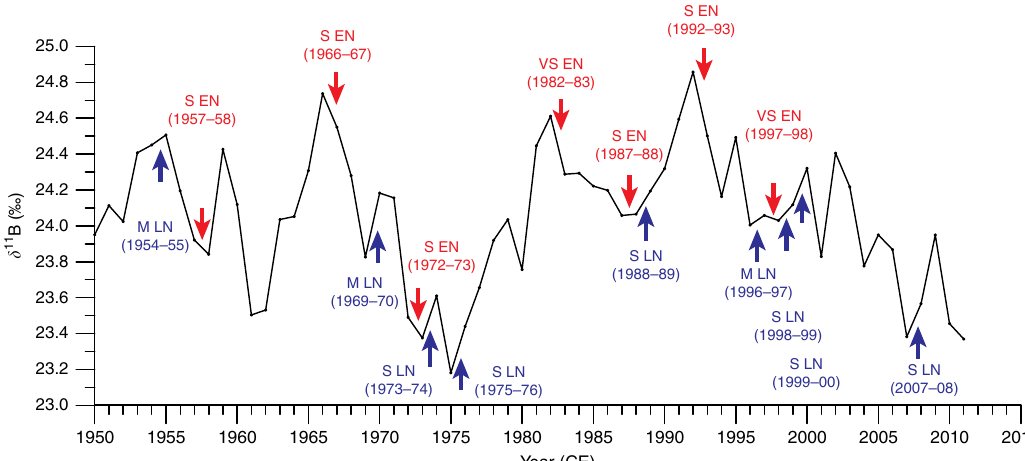
Fig. 5 New Caledonia coral δ 11 B and ENSO events. The New Caledonia coral δ 11 B record from 1950 – 2011 CE with recent ENSO events identi fi ed (Table 2). The severity of the listed El Niño (EN) or La Niña (LN) events are identi fi ed by the Oceanic Niño Index (ONI) from the 3-month running mean SST anomaly that is above or below the 0.5 °C threshold for a period of at least 5 months in the Niño 3.4 region based on ERSST version 4 (ref. 33 ). The threshold of ENSO event is broken down into categories of moderate -M- (±1.0 – 1.4 °C), severe -S- (±1.5 – 2.0 °C) and very severe -VS- (>±2.0